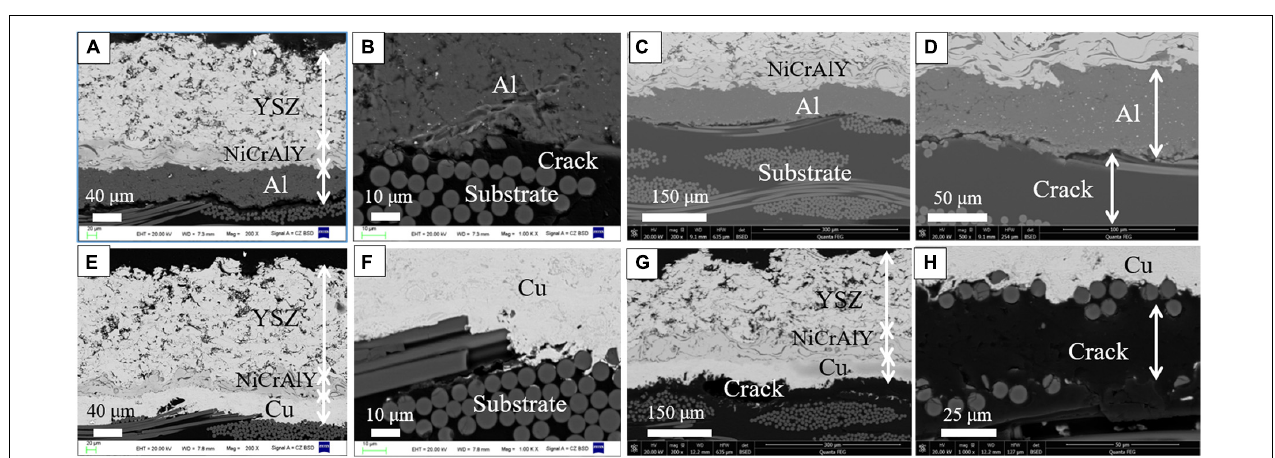
FIGURE 2 | Thermophysical properties of coating C50N50Y200.